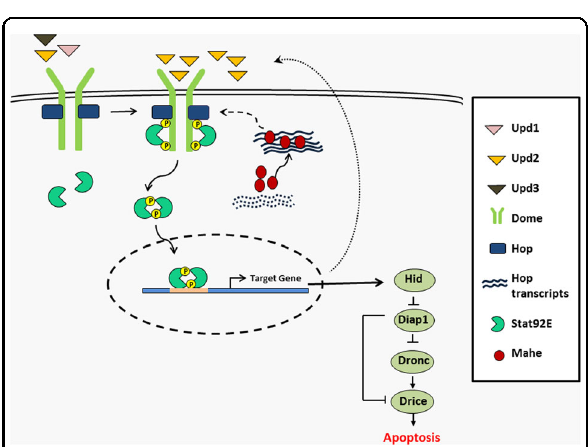
Fig. 7 A hypothetical model depicting recruitment and stabilization of hop kinase transcripts by RNA helicase Mahe which leads to activation of JAK/STAT signaling and primes hid mediated apoptosis. Our model depicts that Mahe encoding an RNA helicase binds and regulates hop transcript stability, and this results in the increase in levels of Hop kinase. This upregulation of Hop tyrosine kinase leads to enhanced phosphorylation and activation of transcription factor Stat92E which enters into the nucleus, resulting in downstream target gene activation. An auto feedback loop is re fl ected by increase in the levels of Upd2, and thus the JAK/STAT signaling remains in an active state. This activated JAK/STAT signaling then induces hid mediated